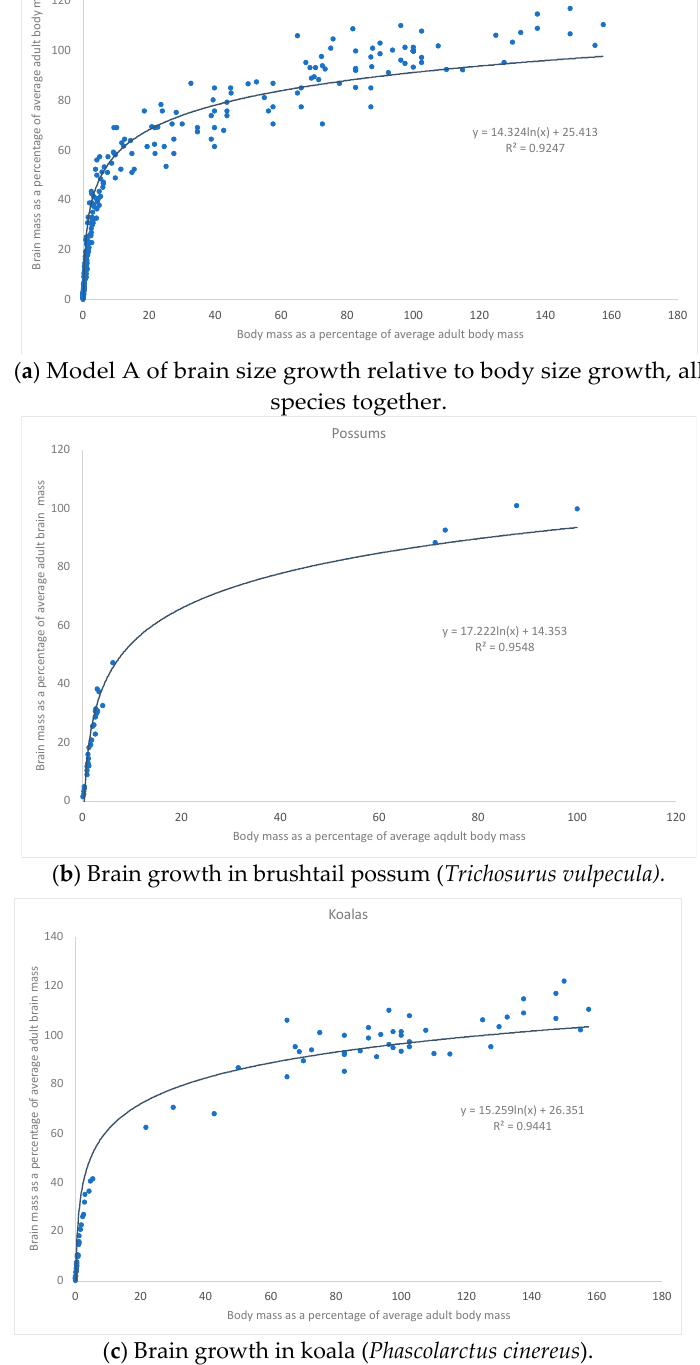
Body mass as a percentage of average adult body mass ( c ) Brain growth in koala ( Phascolarctus cinereus ). Wallabies Figure 1. Cont